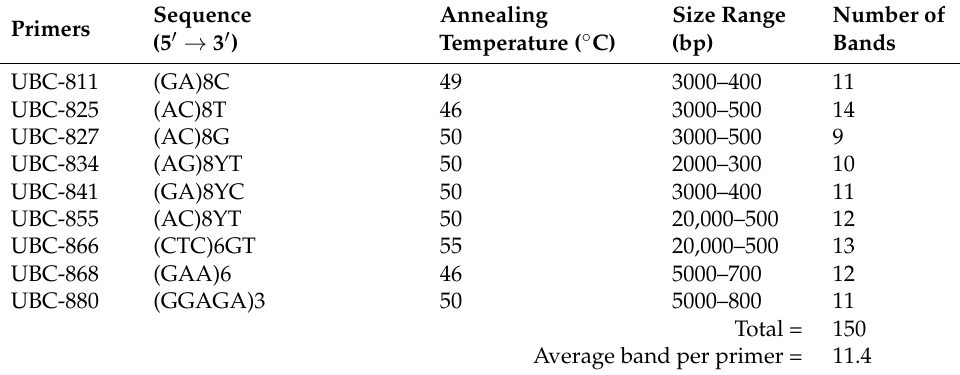
Table 2. ISSR primers screening for the genetic stability of Plectranthus amboinicus